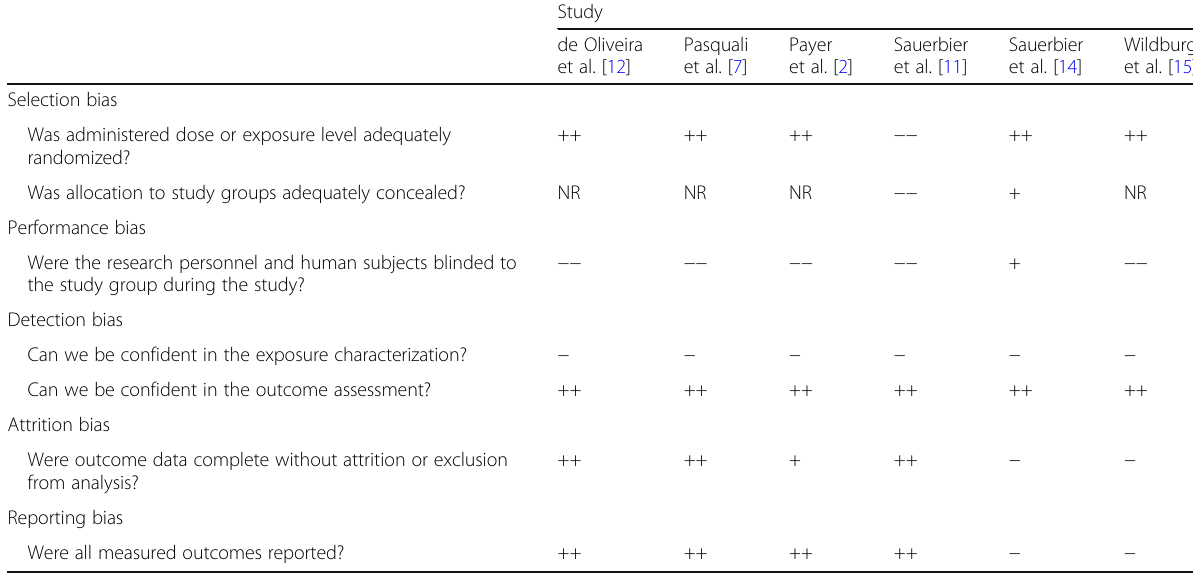
Table 1 OHAT risk of bias